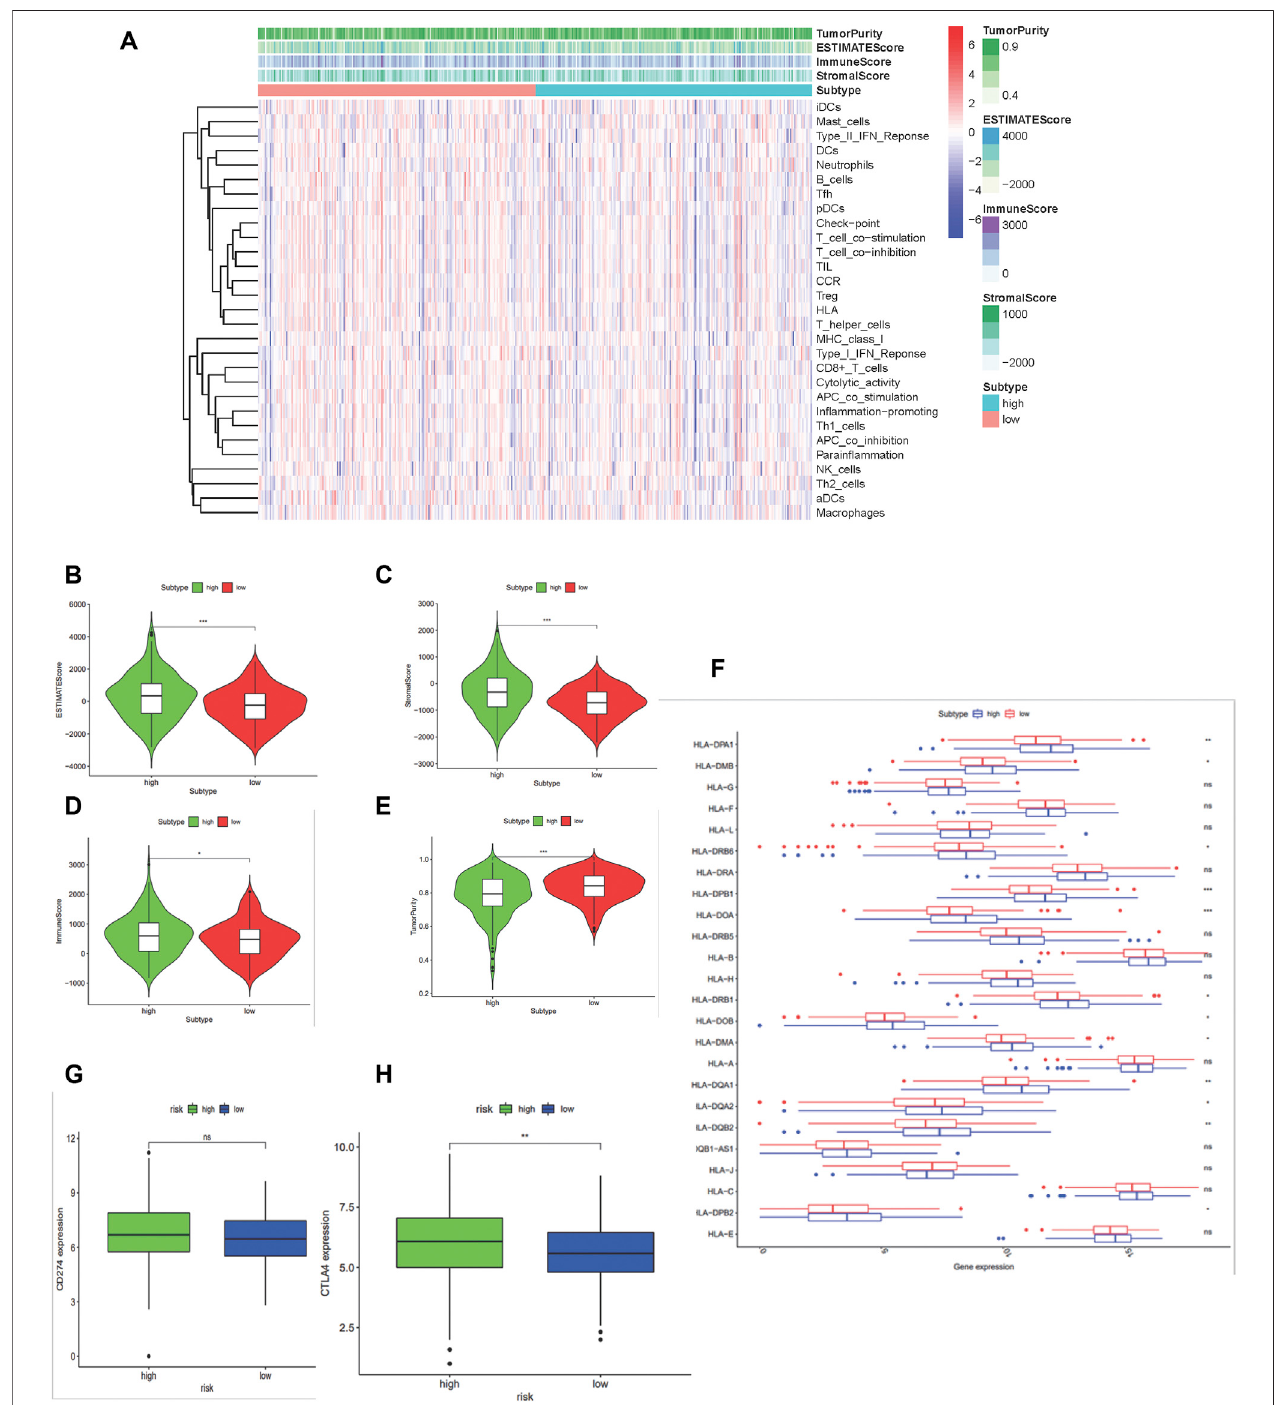
FIGURE 5 | Construction and certi fi cation ofmtDNA-related patients groups in colon carcinoma samples. (A) Binary riskgroup constructed by LASSO regression analysis of 475 DGEs and further validated using the ESTIMATE algorithm. (B – E) Differences of scores calculated by the ESTIMATE between the high-risk and low-risk group. (F) Boxplot shows the expression of HLA family genes. (G – H) Expressions of PD-L1 (CD274) and CTLA4. (*: p < 0.05 **: p < 0.01 ***: p < 0.001).